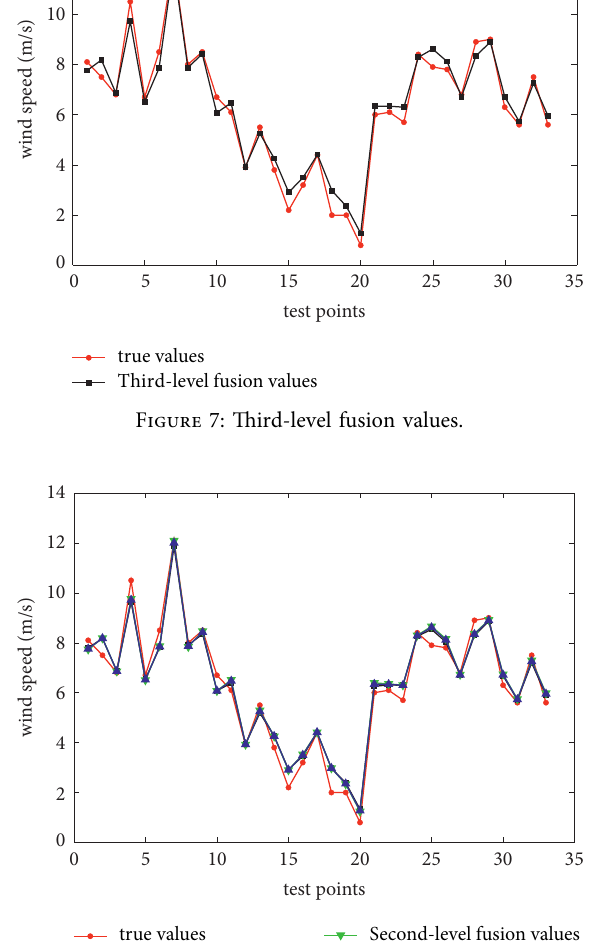
Figure 8: Fusion value comparison.